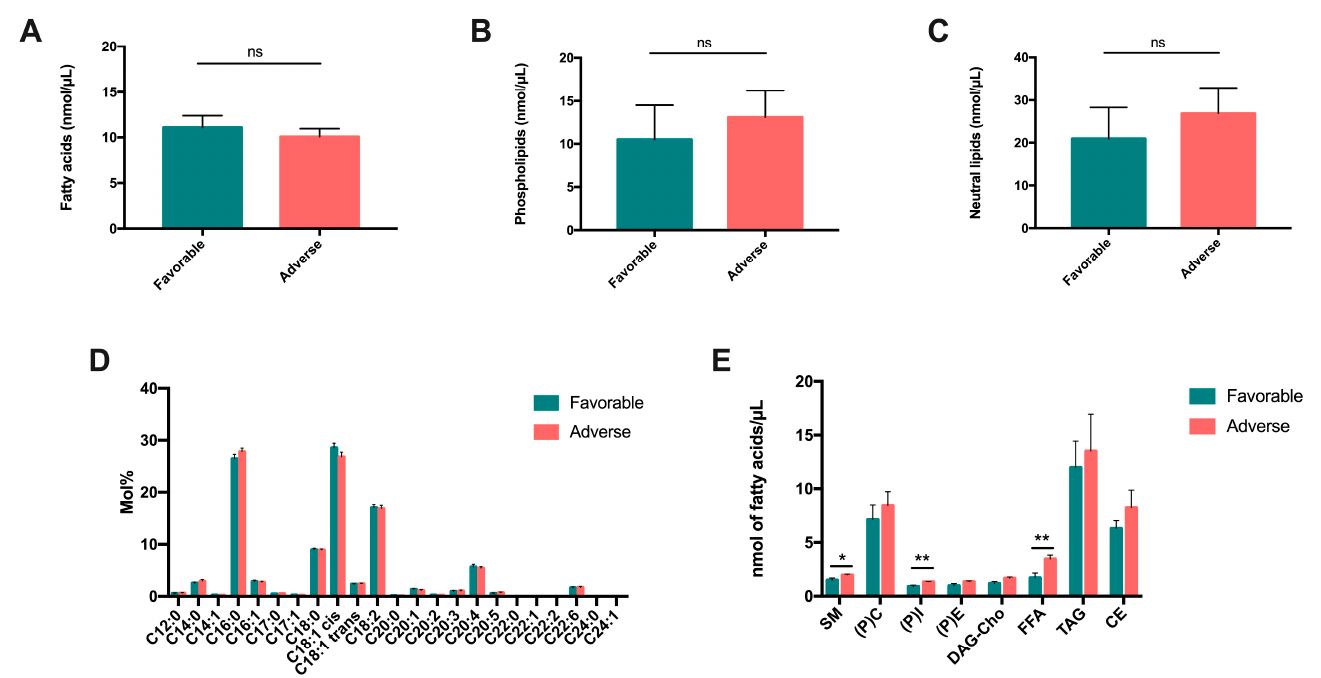
Figure 6. Variation in fatty acid content and lipid species in AML patients according to their prognosis. The amounts of total fatty acids ( A ), phospholipids ( B ) and neutral lipids ( C ) were quantified in patients with favorable and adverse prognoses. ( D ) Composition of total fatty acids in plasma of patients with favorable and adverse prognoses. ( E ) Lipid species quantification in plasma of patients with favorable (n = 5) versus adverse (n = 5) prognoses. ns: non-significant, * p < 0.05, ** p < 0.01.